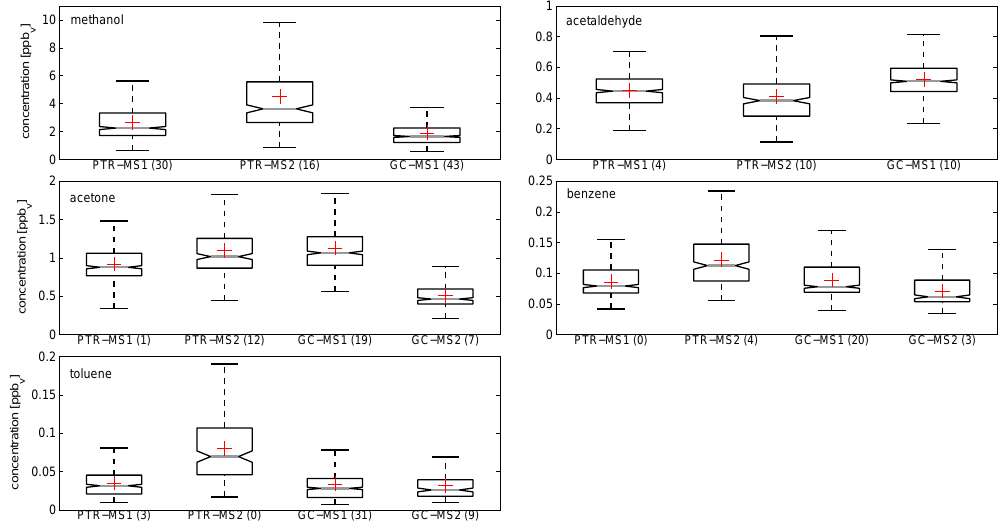
Figure 4. Median concentrations and 25th and 75th percentiles of methanol, acetone, acetaldehyde, benzene and toluene. Red plus signs show the arithmetic mean concentrations. The whiskers illustrate the most extreme data points, which are not considered outliers (99.3%) and the notches show the 95% confidence interval of the median value. In order to make the figure more clear, outliers are not shown. The numbers next to the instrument names indicate how many outlier points were removed in each